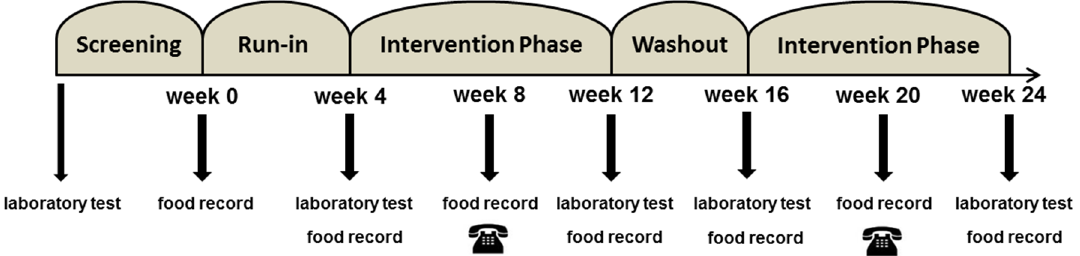
Figure 2. Flowchart of study procedures.